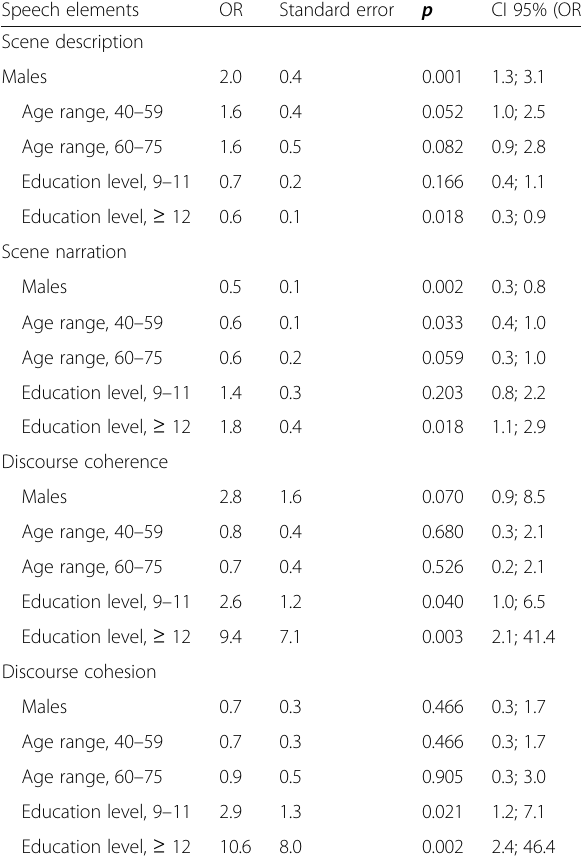
Table 2 Analysis by logistic regression to evaluate the influence of demographic data in discourse Speech